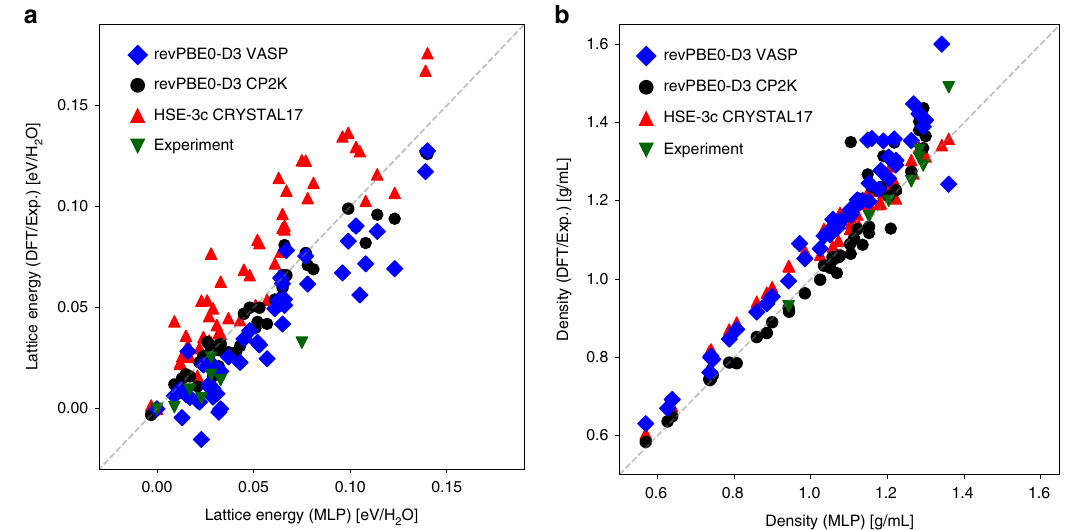
Fig. 2 A comparison between the lattice and energy of the 54 ice phases. The x -axes show the values computed using the MLP based on revPBE0-D3. a Results for lattice energy, and b shows the values for the densities of the ice phases. In both panels, the y -axes show the results from DFT calculations using the revPBE0-D3 functional employing VASP , the revPBE0-D3 functional employing CP 2 K , and the HSE-3c functional employing CRYSTAL 17. The experimental references are taken from ref. 59 : the densities were measured at between 0 and 90 K and ambient pressure, and the experimental lattice energies were extrapolated to 0 K, and zero-point energies were removed. Source data are provided as a Source Data fi